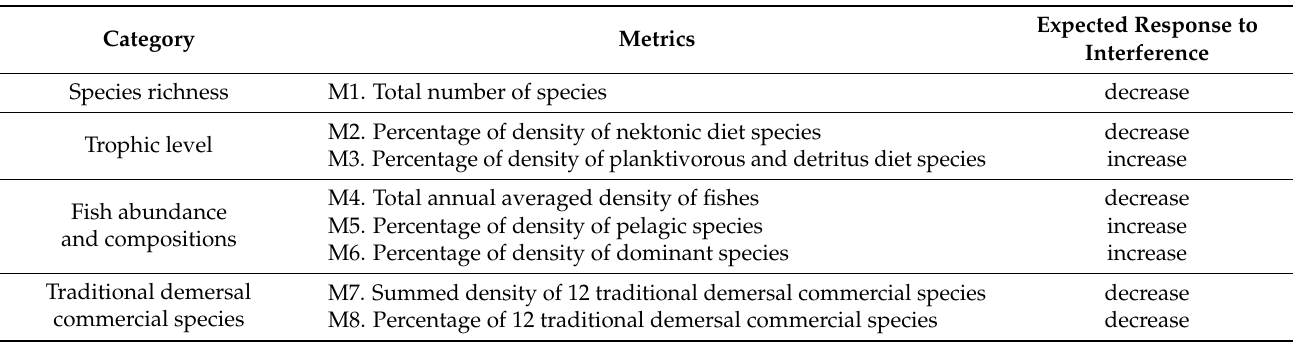
Table 2. Metrics for fish integrity biotic index (F-IBI) and their expected responses to